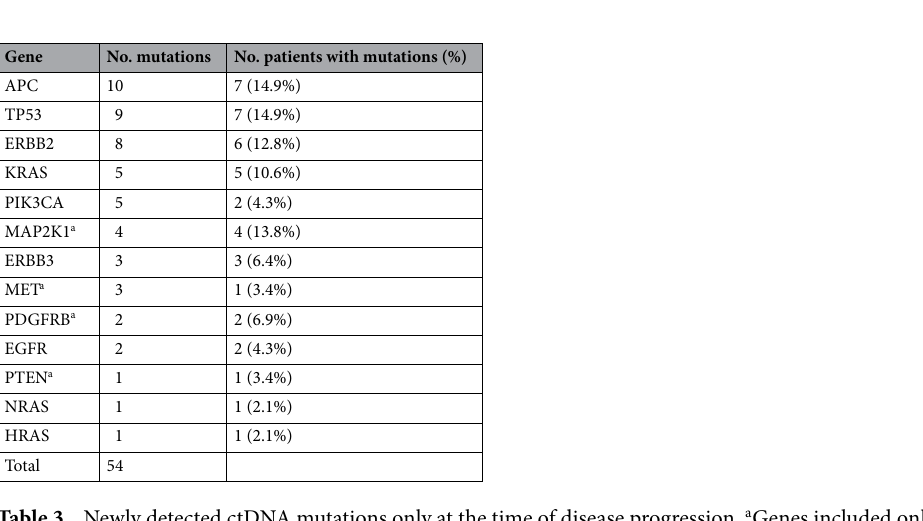
Table 3. Newly detected ctDNA mutations only at the time of disease progression. a Genes included only in panel version 3 used for PD ctDNA analysis of 34